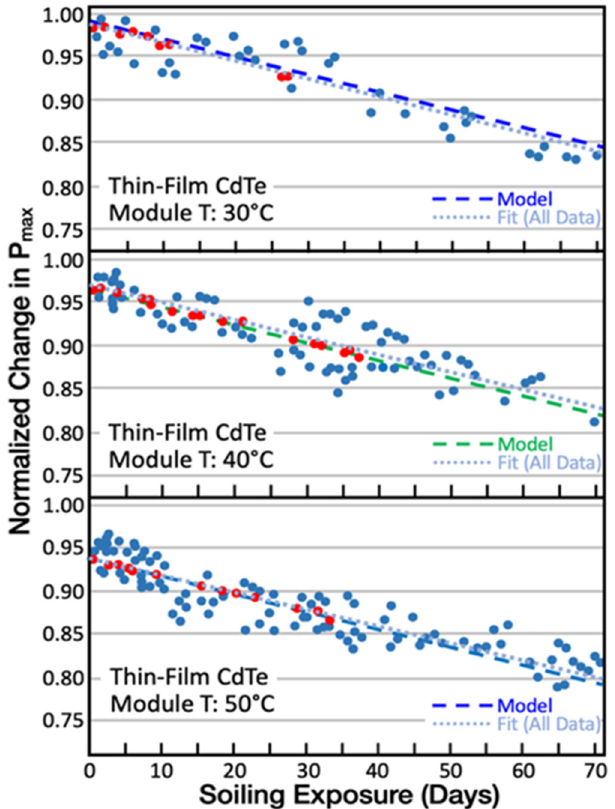
Figure 9. Normalized P max for CdTe modules at different temperatures as a function of the soiling exposure in Belo Horizonte, Brazil. The model predictions (solid lines) are included as well as a corresponding linear fit to the data (dotted lines). The red data points are for an extended single, dry period (37 days) showing better fit to the model predictions.